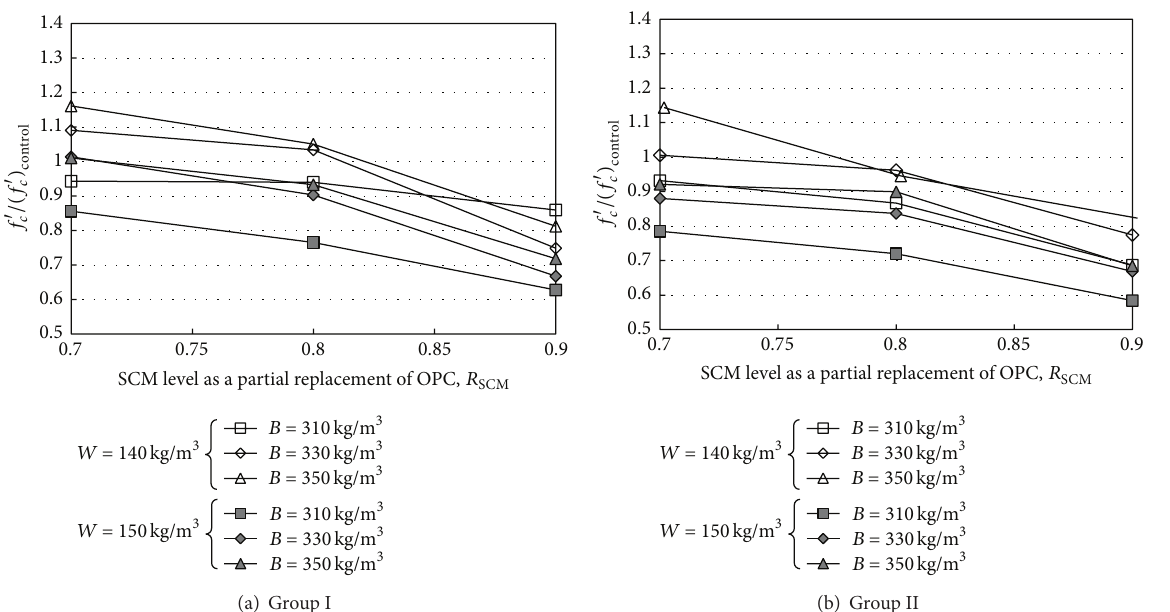
Figure 2: Relative 28-day strength of very-high-volume concrete as compared to control